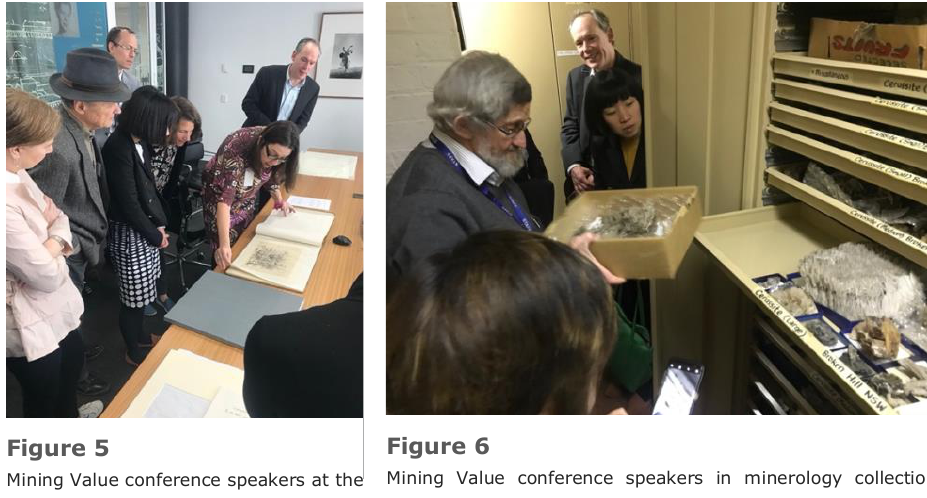
Figure 6 Mining Value conference speakers in minerology collection storage at the Australian Museum, Sydney, August